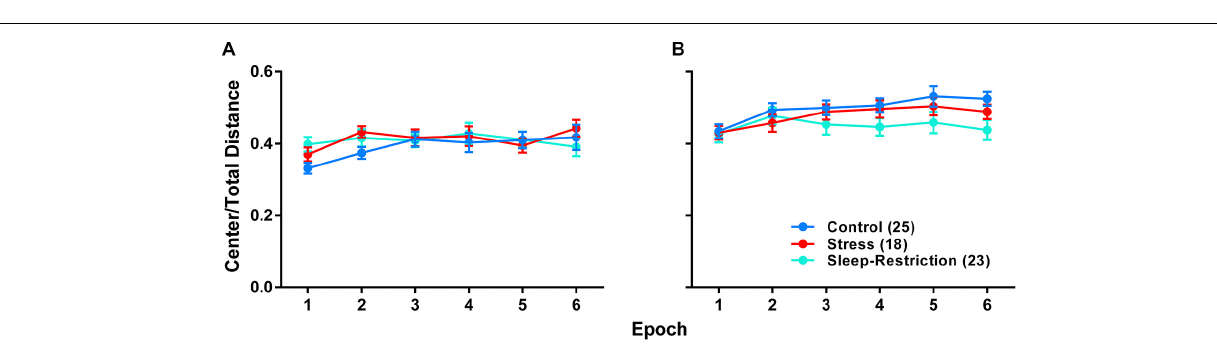
FIGURE 5 | Effects of stress and sleep-restriction on anxiety-like behavior at P42 (A) and following recovery at P84 (B) . Results of ANOVA are given in Table 2 . Both the condition × epoch ( p = 0.059) and age × condition ( p = 0.070) interactions approached statistical significance suggesting that, regardless of age, stress and sleep-restriction changed the habituation response to the novel environment. Each point represents the mean ± SEM for the number of mice indicated in